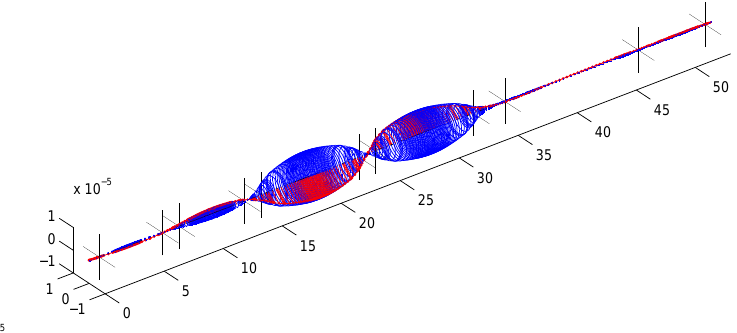
Figure 11. Visualization of the rotor mode shape with dominant deformation of the low pressure rotor parts (calculated using model A).